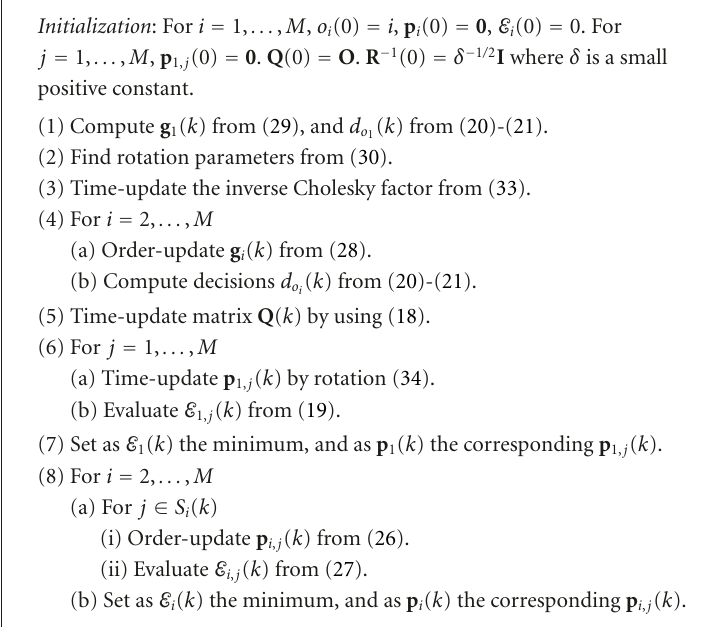
Algorithm 1: The proposed SROC